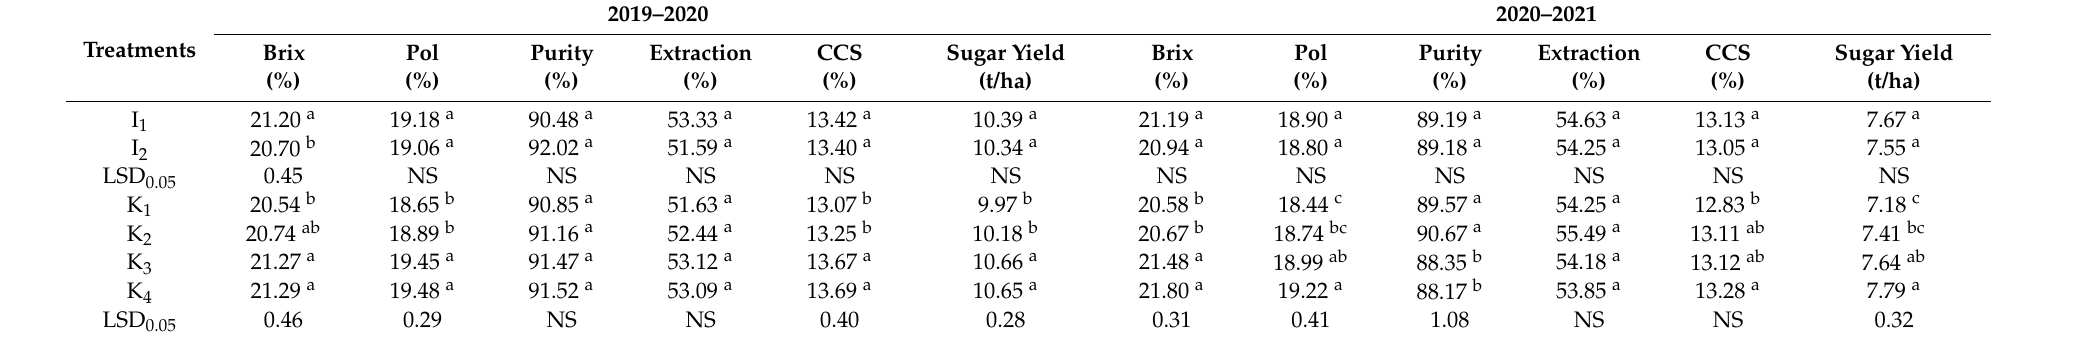
Table 10. Sugarcane quality parameters at 12th months as a function of irrigation and potash levels.